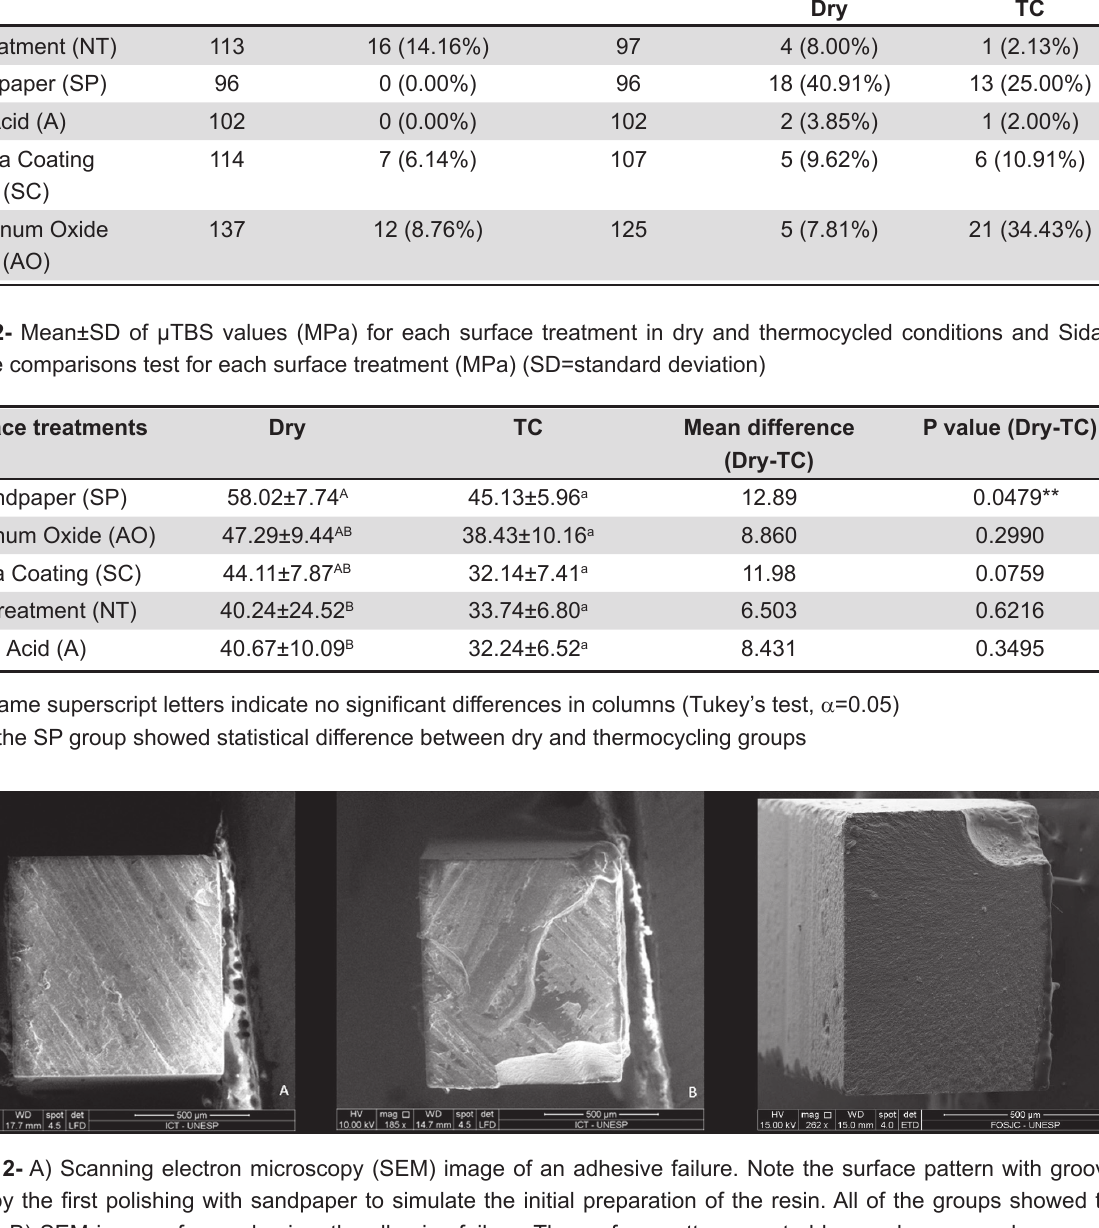
Figure 2- A) Scanning electron microscopy (SEM) image of an adhesive failure. Note the surface pattern with grooves made by the first polishing with sandpaper to simulate the initial preparation of the resin. All of the groups showed this pattern; B) SEM image of a predominantly adhesive failure. The surface pattern created by sandpaper can be seen; C) SEM image of a cohesive failure. Note that the surface pattern created by sandpaper is smoother in this type of